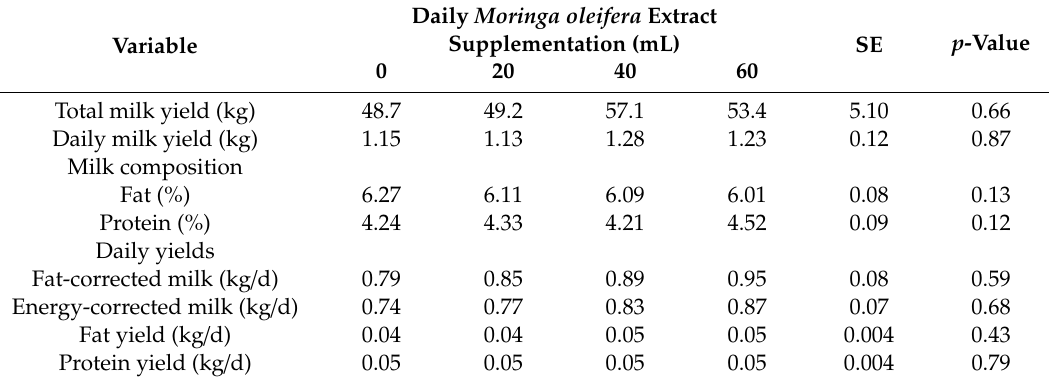
Table 3. Milk yield and composition in Pelibuey × Katahdin ewes supplemented with Moringa oleifera leaf extract.